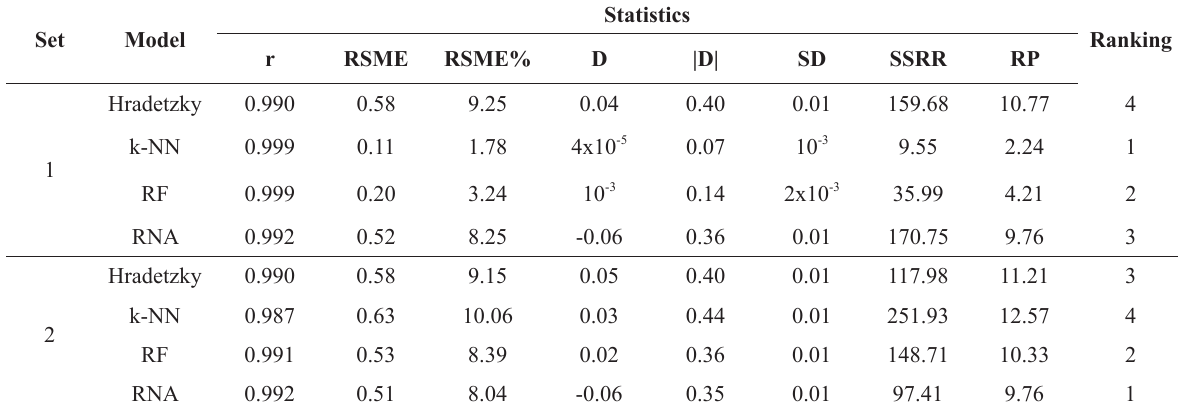
Fit statistics for diameter estimate along the stem fortraining (1) and validation (2)